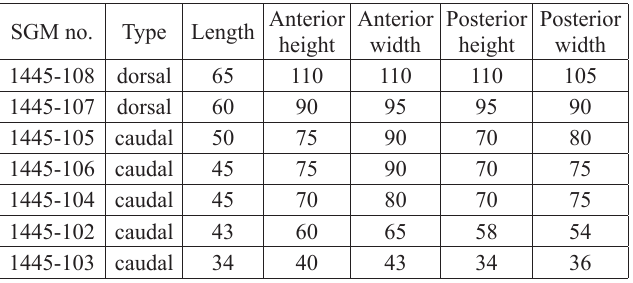
Table 1. Measurements (in mm) of the preserved plesiosaurian verte- bral centra of SGM 1445-9–20, 97 − 120. SGM no.